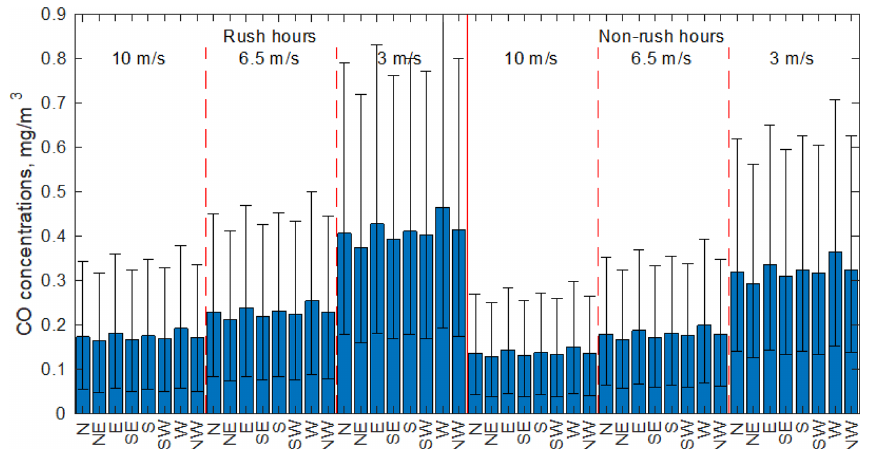
Figure 8. Mean modeled ground-level CO concentrations (with 30% and 70% percentiles) over the whole model domain with different wind speeds, wind directions, and emission